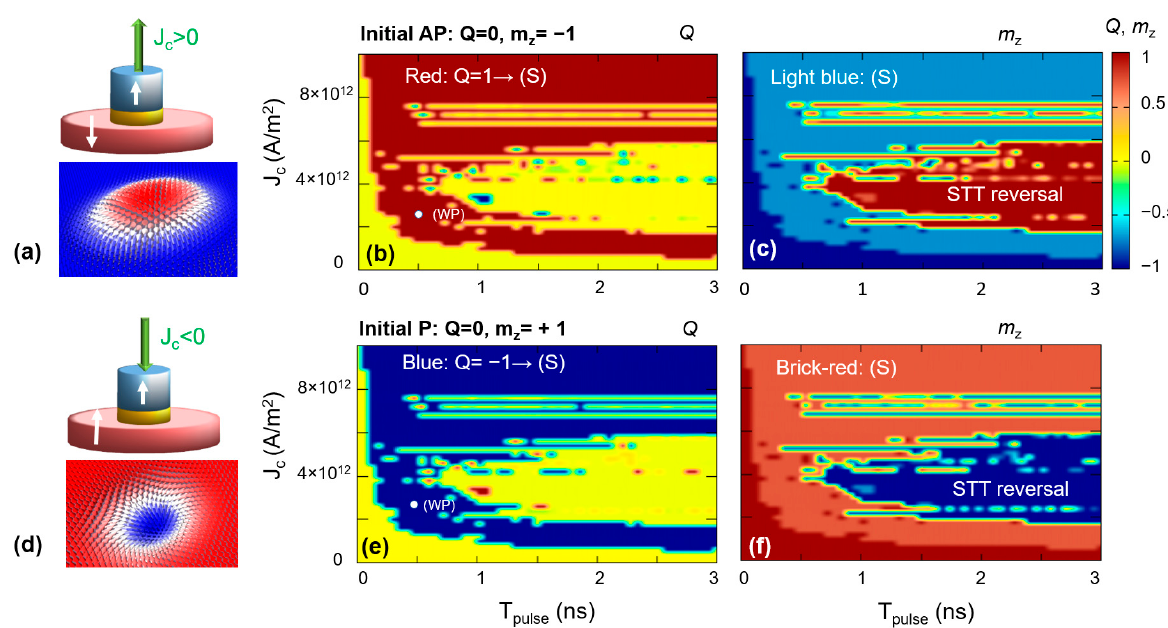
Figure 10. ( a , d ) Simulation geometry and final skyrmionic state magnetization vector field used in skyrmion writing by STT. T pulse -J c -Q and T pulse -J c -m z phase diagrams, starting either from an initial antiparallel (AP) state ( b ) and ( c ) or parallel ( P ) state ( e ) and ( f ).